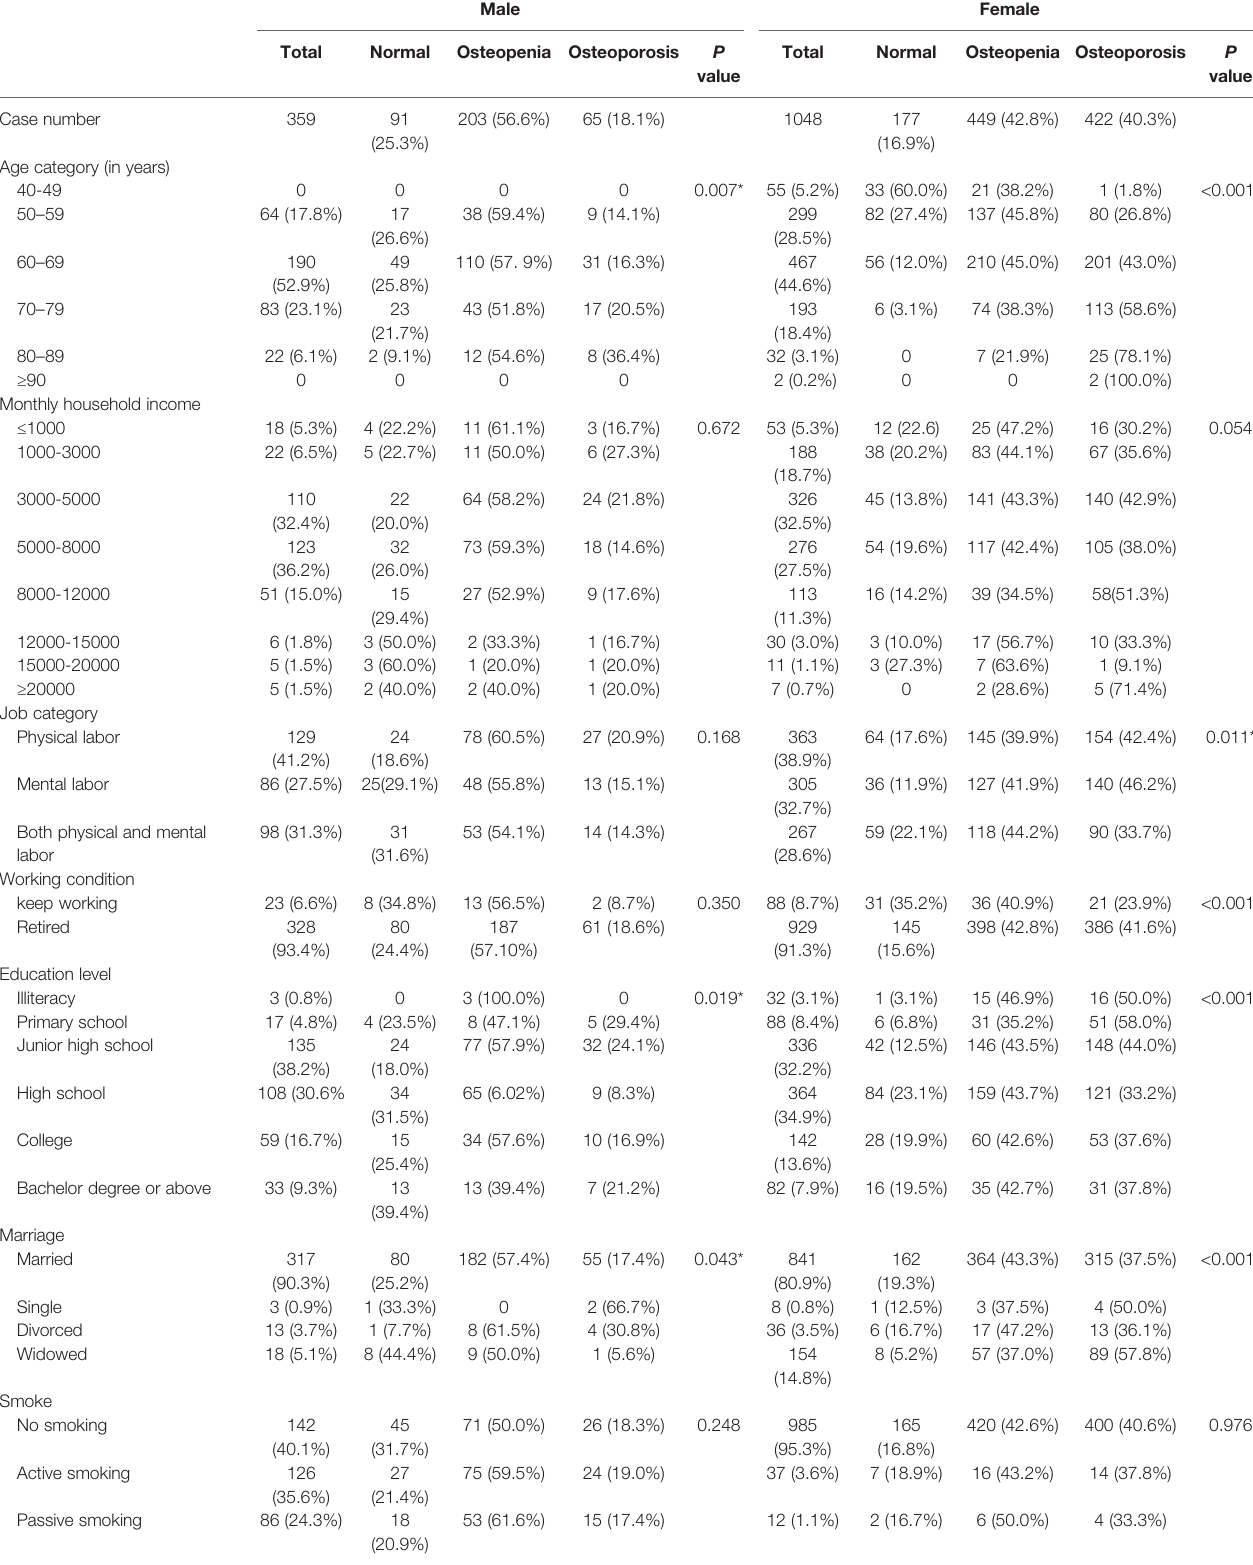
TABLE 2 | Baseline characteristics of study participants grouped by osteoporosis